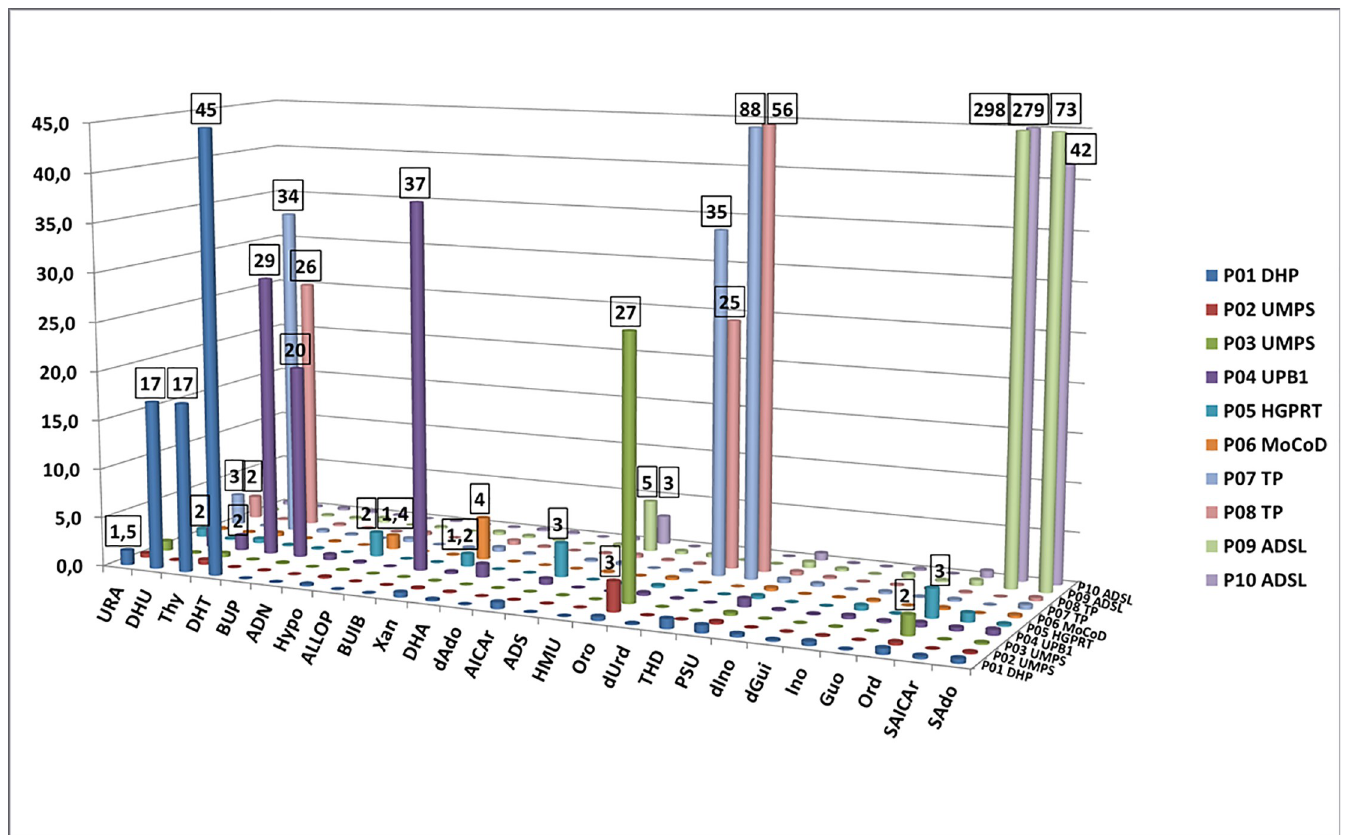
Fig 2. Results of urine samples from patients with known diagnosis ( n = 10). Numbers on the cylinders show how many times a given result exceeded the respective cutoff for that biomarker. Abbreviations are provided in the List of Abbreviations Section. The Y-axis has been cut at 45 for a better visibility. Note that orotidine is not pathognomonic for HGPRT (sample P05) but is accumulated as a result of allopurinol treatment.